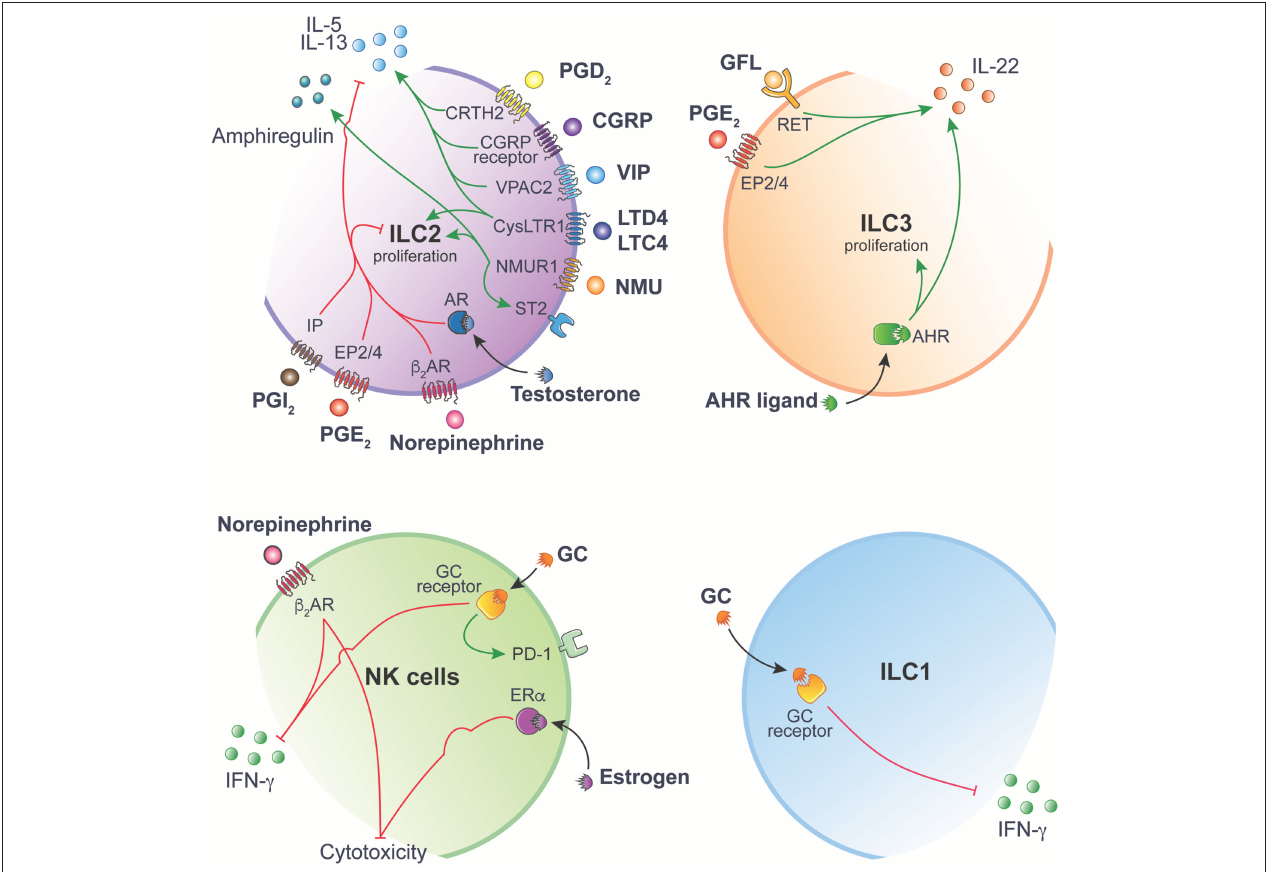
FIGURE 2 | ILC function is tightly regulated by ligand-receptor interactions. Inhibitory and activating intracellular pathways are colored in red and green, respectively. This figure has been drawn using Servier Medical Art (https://smart.servier.com) and modified by the authors under the following terms: Creative Commons Attribution 3.0 Unported